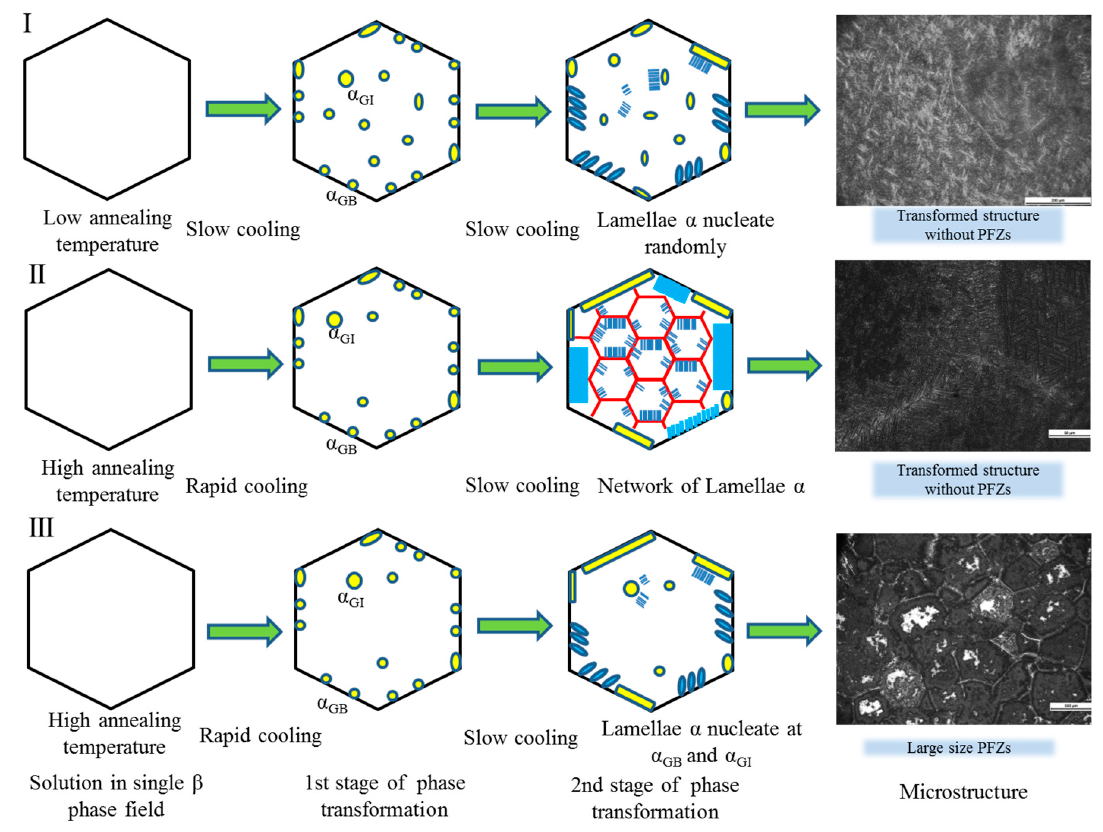
Figure 11. Schematic illustration of the nucleation modes in β - α phase transformation.